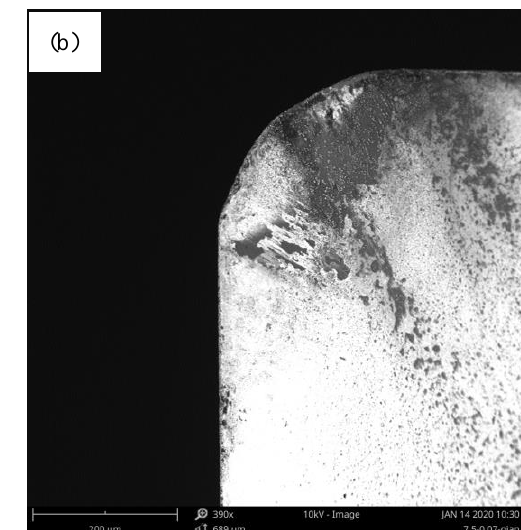
Figure 15. The wear morphology of rake face at 1200 m/min when the milling length reached ( a ) 5 m; ( b ) 7.5 m.